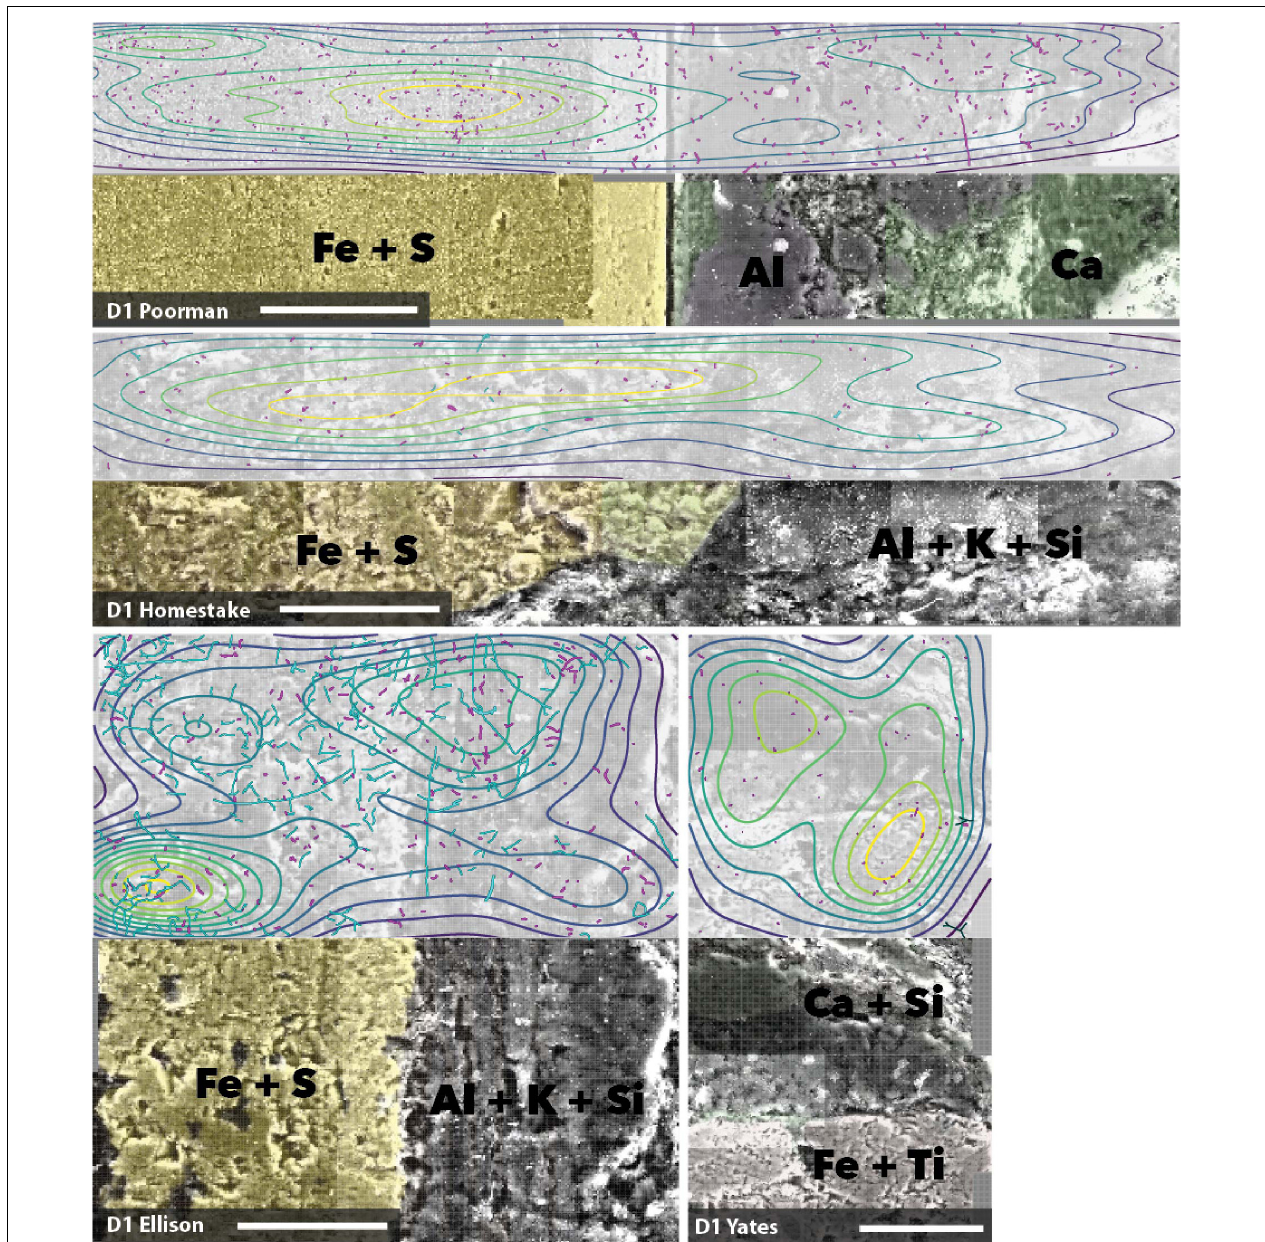
FIGURE 6 | Coupled SEM/XEDS images of D1 biofilms on native rock coupons from selected experiments. Top panels for each rock type show cell (magenta) and fungal feature (cyan) distribution with kernel density contours where yellow represents the highest density, bottom panels show coupons colored by elements. Transects are stitched images collected at 3000x magnification. Scale bars represent 50 µ